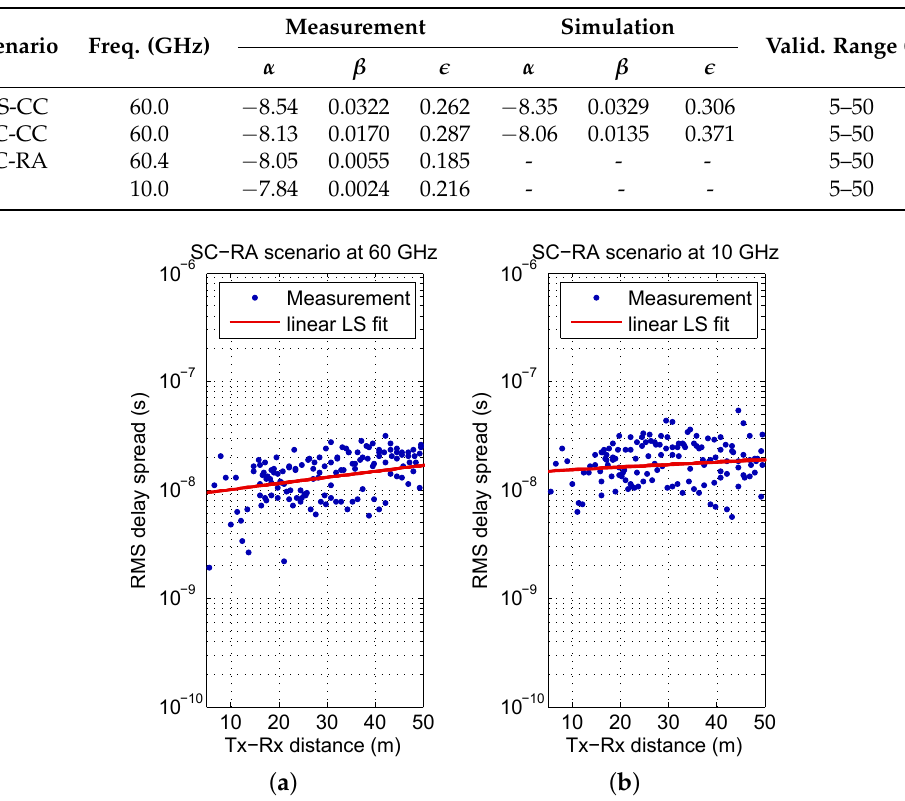
Figure 7. Measured DS as a function of distance with linear LS fit for “street canyon, residential area” (SC-RA) scenario: ( a ) at 60GHz; ( b ) at